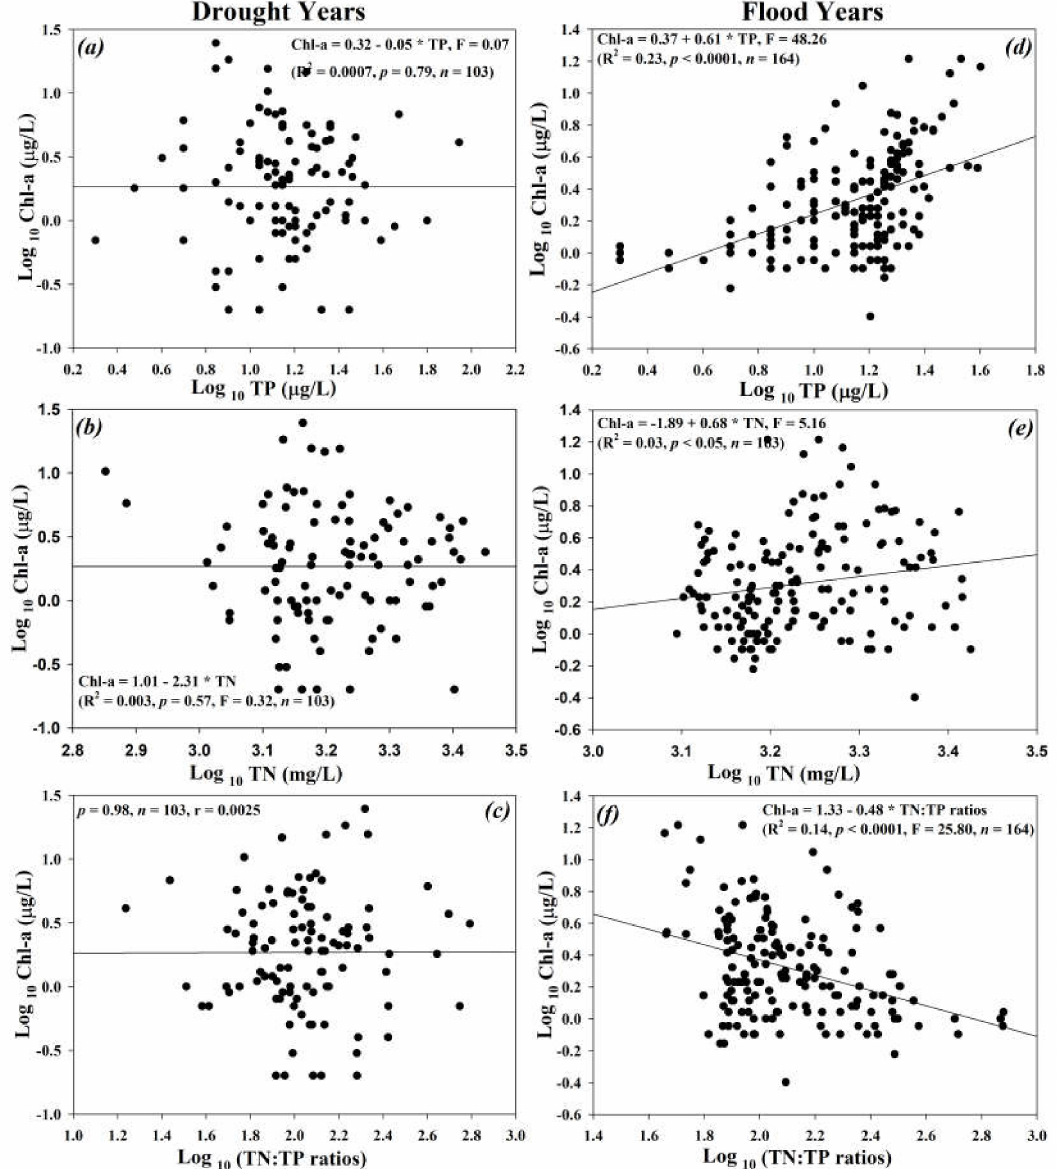
Figure 7. Empirical modeling of Chl-a and nutrients during the flood ( a – c ) and drought ( d – f ) conditions during 1992–2013 in the Soyang reservoir. (*)—multiplication